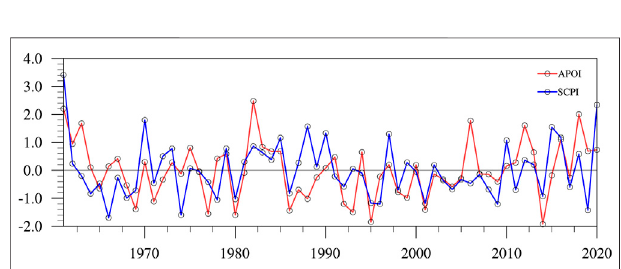
FIGURE 4 | Time series of the normalized SCPI (blue line) and APOI (red